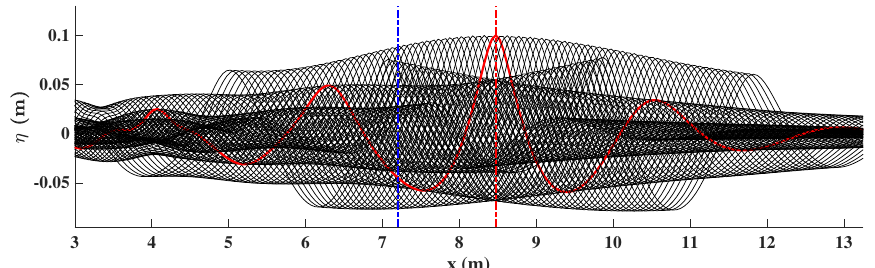
Figure 13. The wave profiles along the longitudinal direction of the wave tank are plotted in one graph at an interval of 0.06 s near t = 10.7 s for the simulation case NING3. The red dash-dot line indicates the real focusing location in the NWT at x = 8.475 m. The blue dash-dot line indicates the designated focusing location at x = 7.2 m. The red curve is the wave profile at the real focusing time.